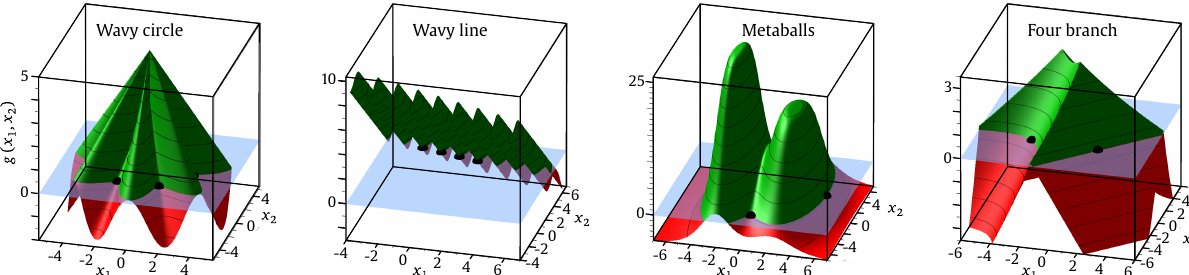
Figure 5. Overview of four two-dimensional examples used for demonstration of the proposed method. Design points are visualized using solid black balls.